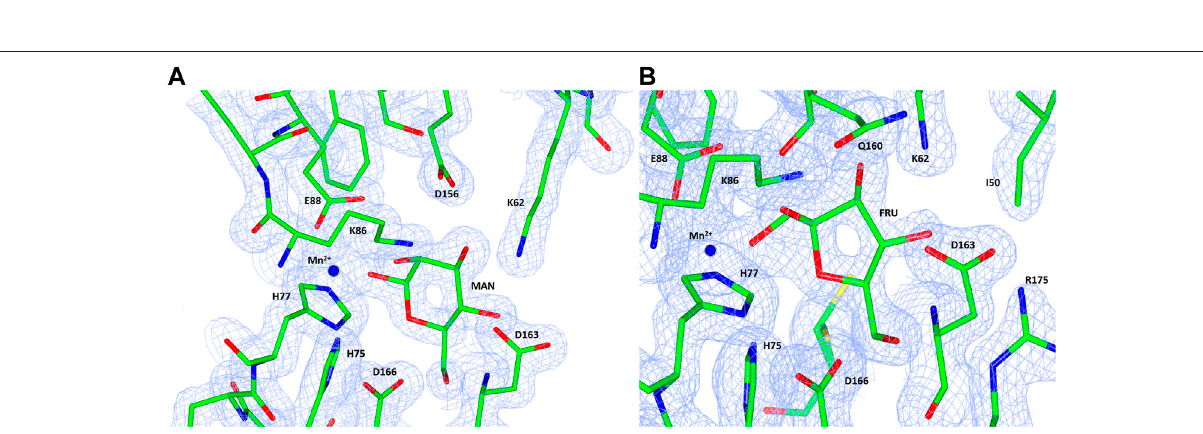
FIGURE 9 | A diagram showing the active sites in the complex structures of TsLI with fructose (A) mannose (B) . The contacts of the ligands with the surrounding amino acid residues are shown as black dashed lines. The manganese ion is shown as a blue sphere with the coordination bonds shown in red.